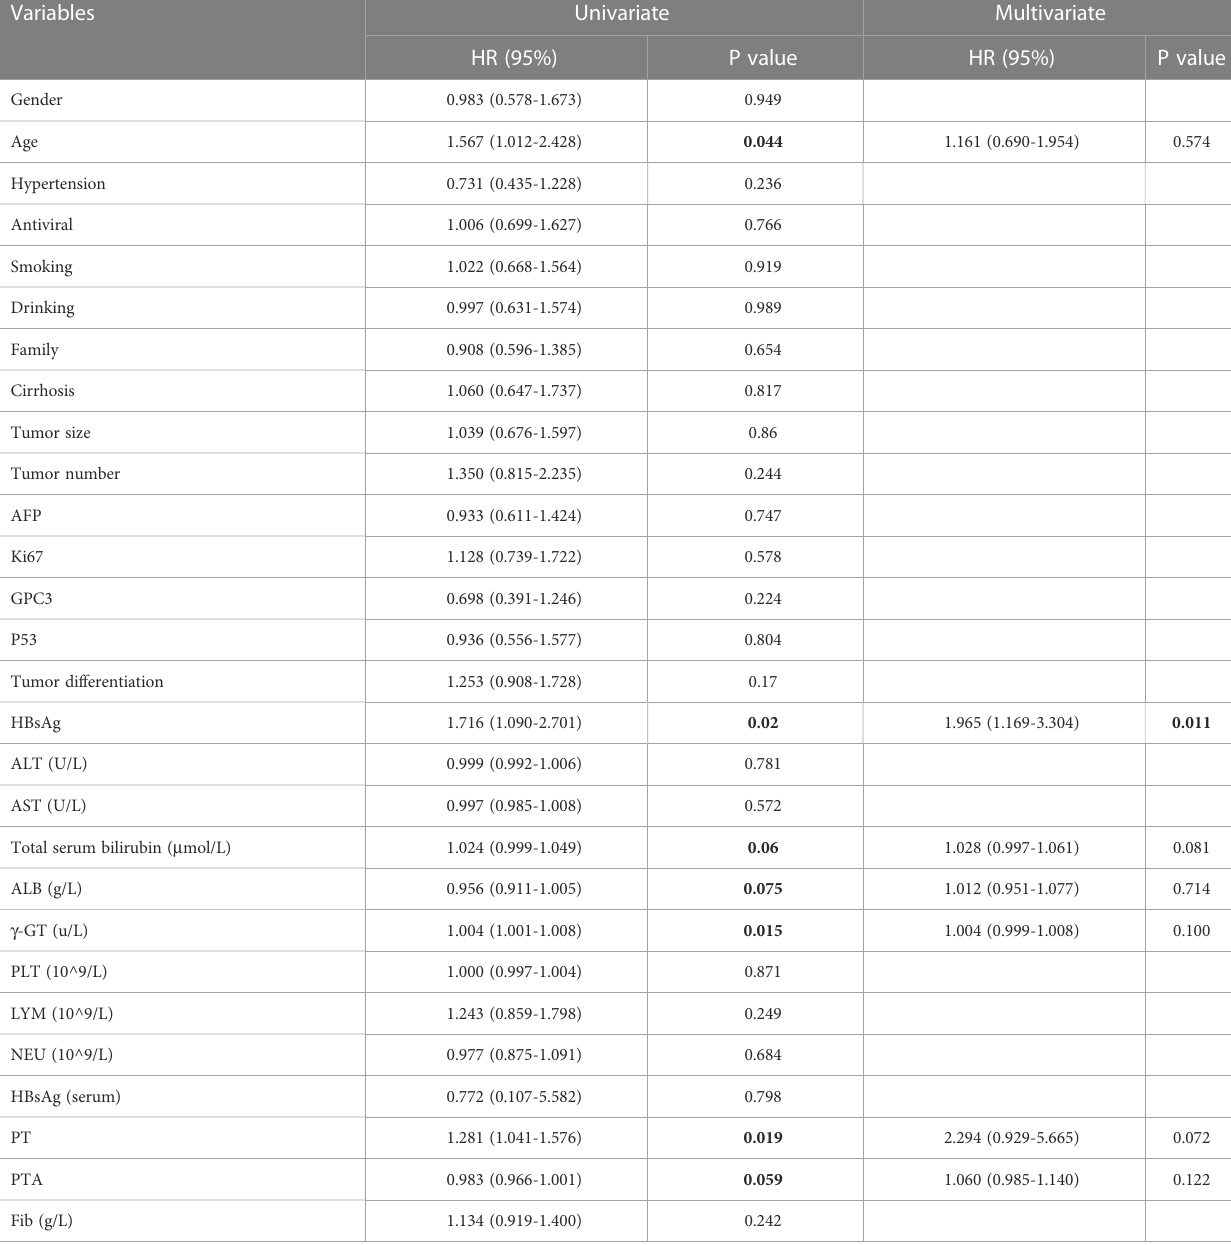
TABLE 2 Prognostic factors for RFS by Cox proportional hazards regression model.